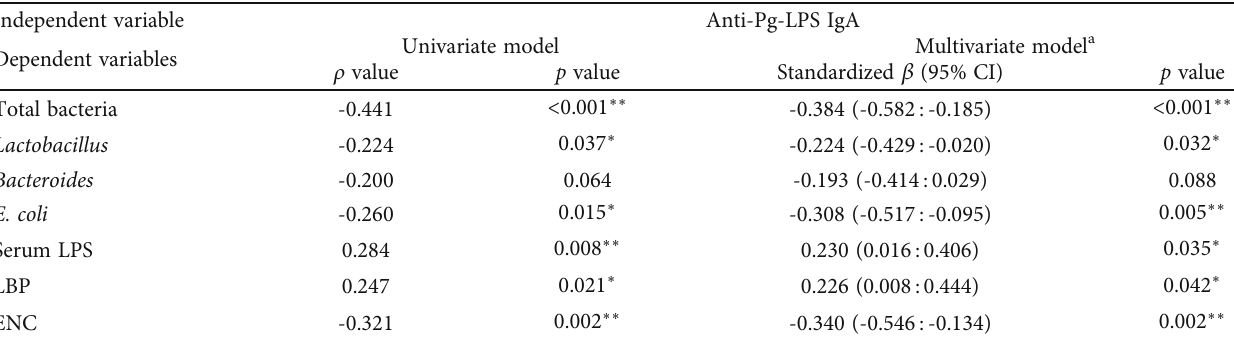
Table 6: Univariate and multivariate regression analyses between serum anti-Pg-LPS IgA levels and bacterial biomarkers. Independent